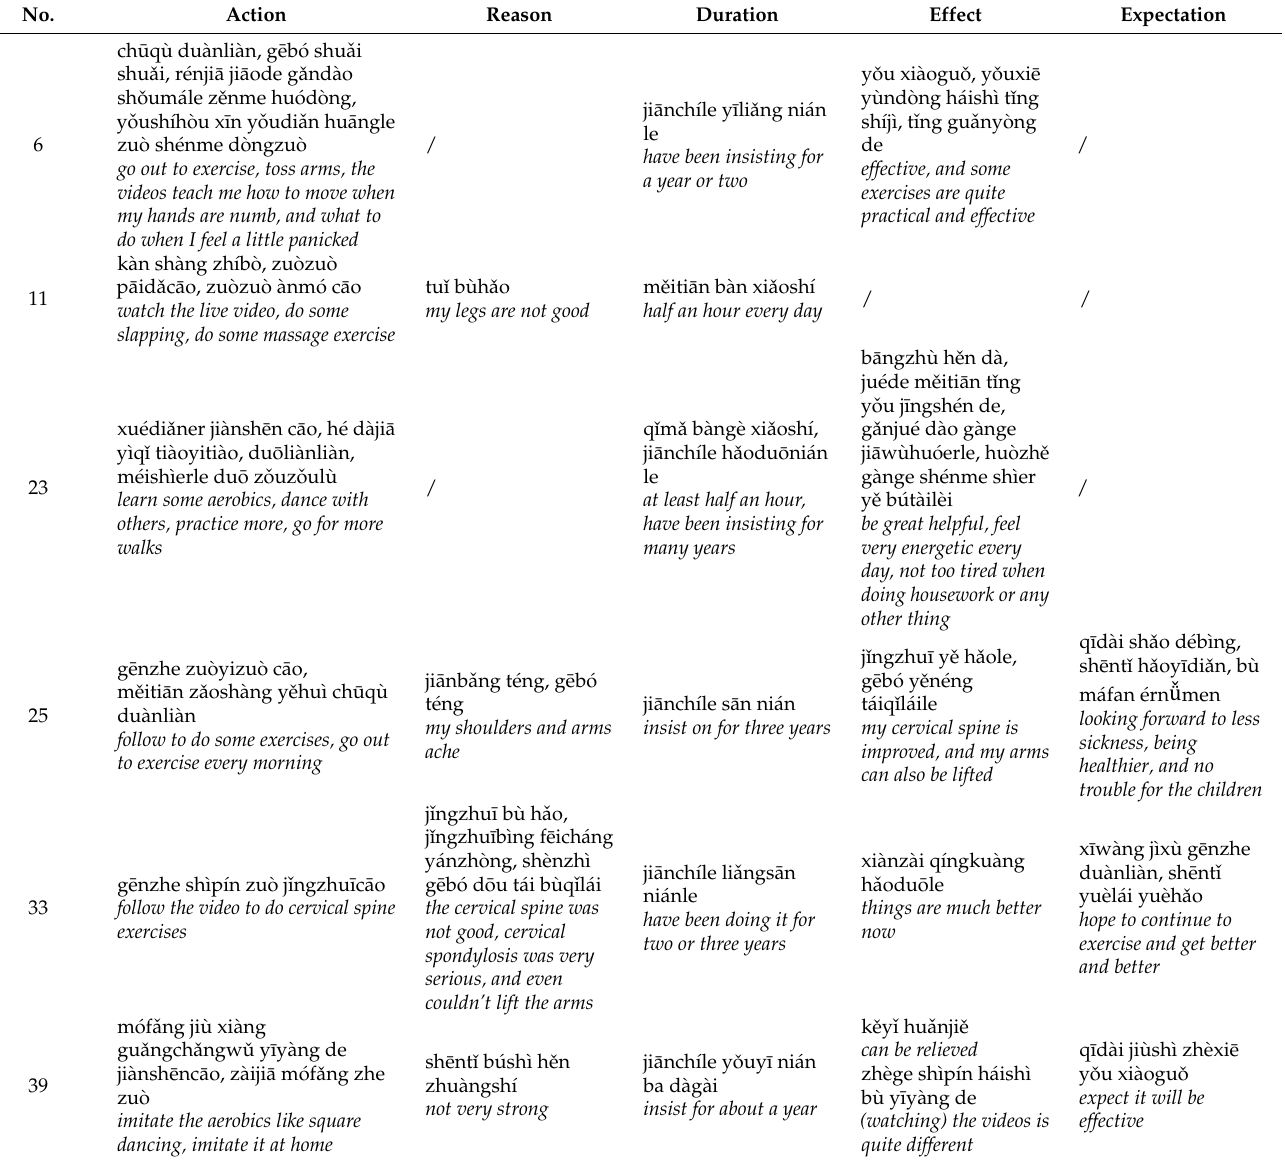
Table 5. Interviewees’ generic statement about the behavioral change through virtual